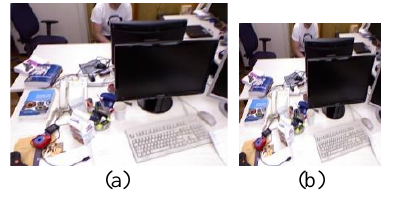
Figure 3 . Schematic diagram of LRF-PoseNet image preprocessing. (a–b) correspond to before and after processed.